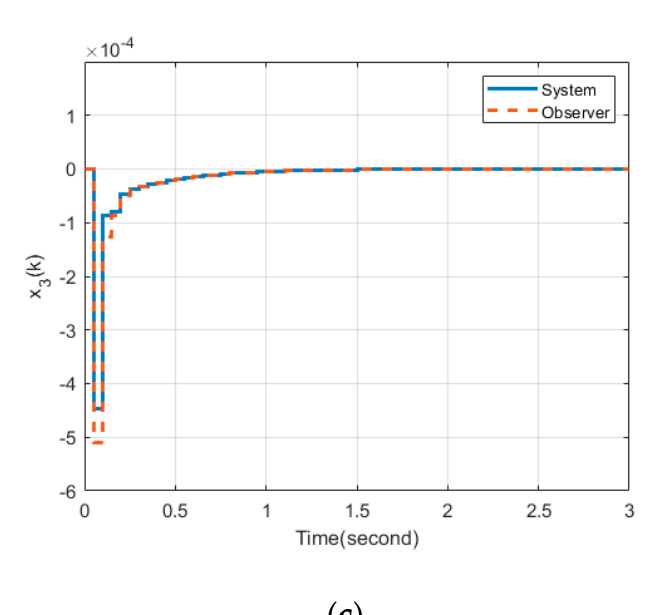
( ) x k ; ( b ) The state and observer responses of 1